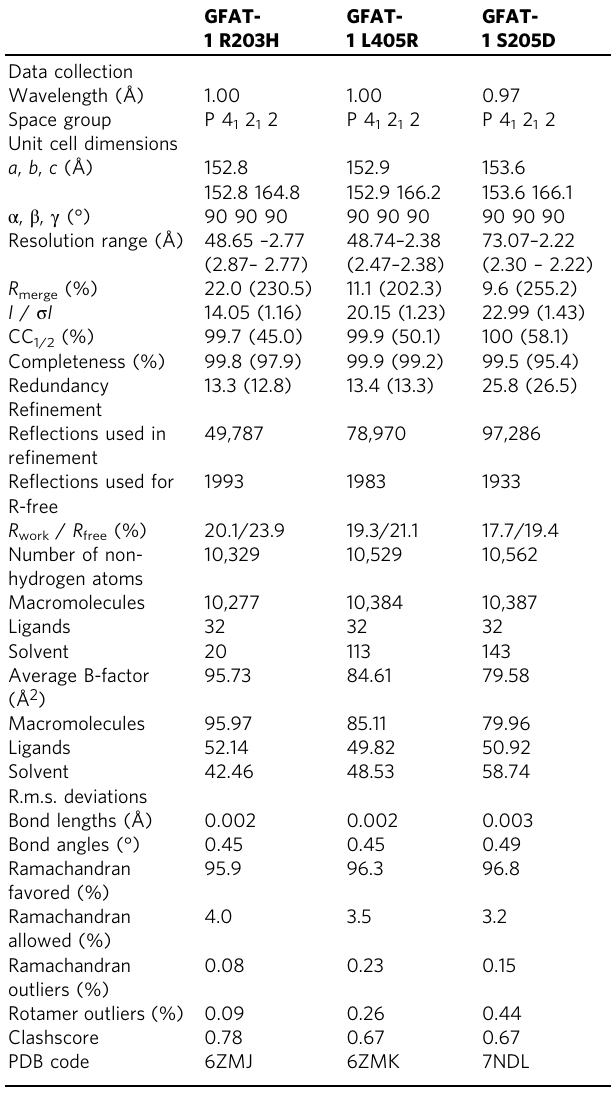
Statistics for the highest-resolution shell are shown in (Fig. 3b). Untreated insect cell-derived wild type and R203H GFAT-1 preparations showed low detectable levels of phos- phorylation at Ser205. In vitro PKA treatment resulted in phos- phorylation of wild type GFAT-1 at Ser205 (Fig. 3c, d). In contrast, the increase of Ser205 phosphorylation was 80-fold